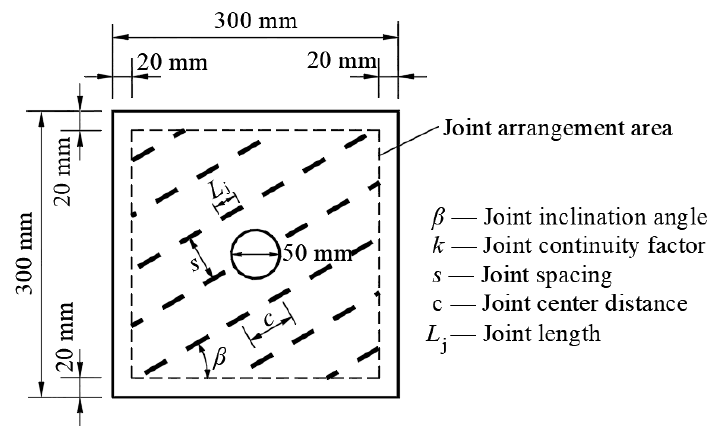
Figure 1. The dimensions of the specimens and geometrical parameters of the joint set.